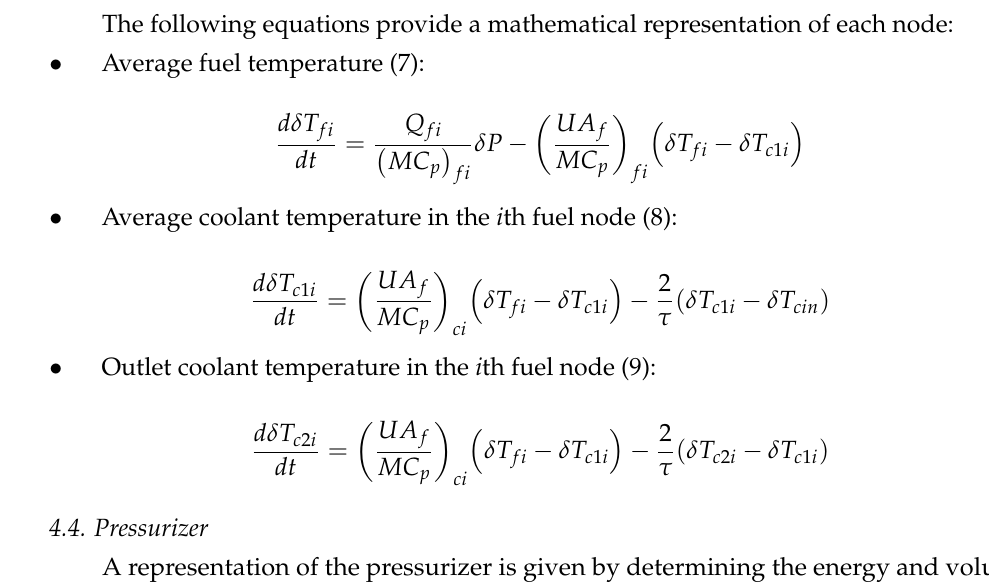
Figure 9. Schematic of the fuel-coolant heat transfer model.